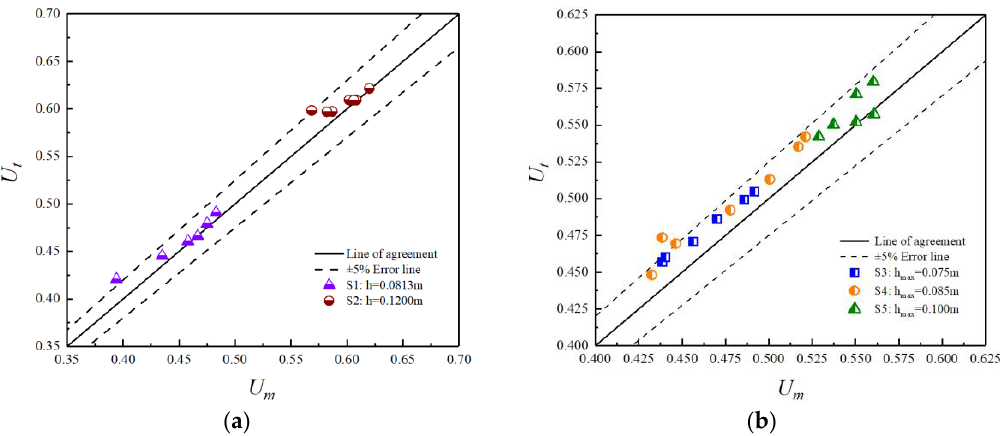
Figure10. Comparisonofmeasuredandtheoreticalvaluesofmeanradialvelocity( a )S1, S2; ( b Figure 10. Comparison of measured and theoretical values of mean radial velocity ( a ) S1, S2; ( b ) S3, S4, S5.